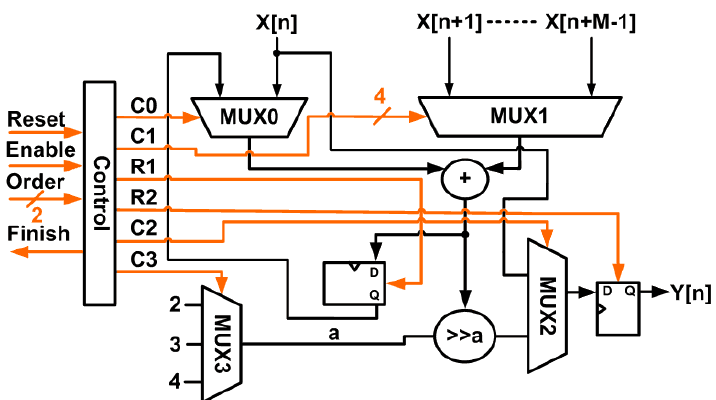
Figure 7. Structure of the moving average